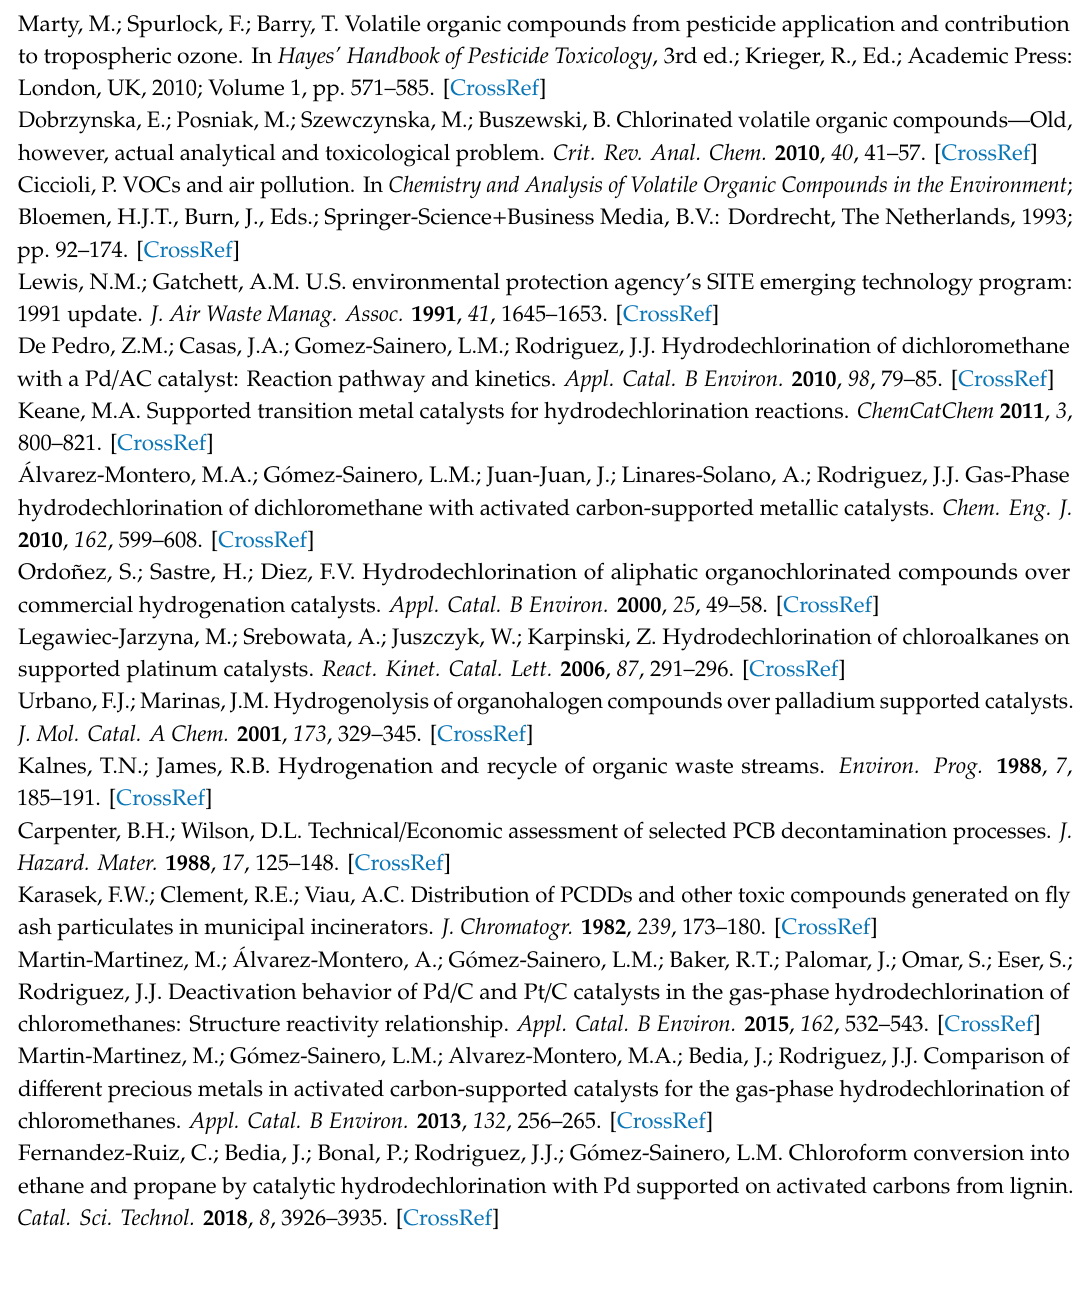
Figure S1: ( a ) XRD patterns of Pd / C (containing bigger Pd particles) used in the deactivation-regeneration study, ( b ) partial detail (di ff raction peaks of metallic Pd (black and blue); di ff raction peaks of PdC x